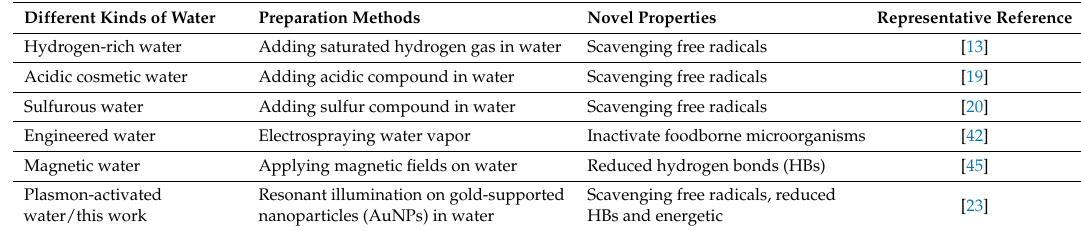
Table 1. The published functional water in the